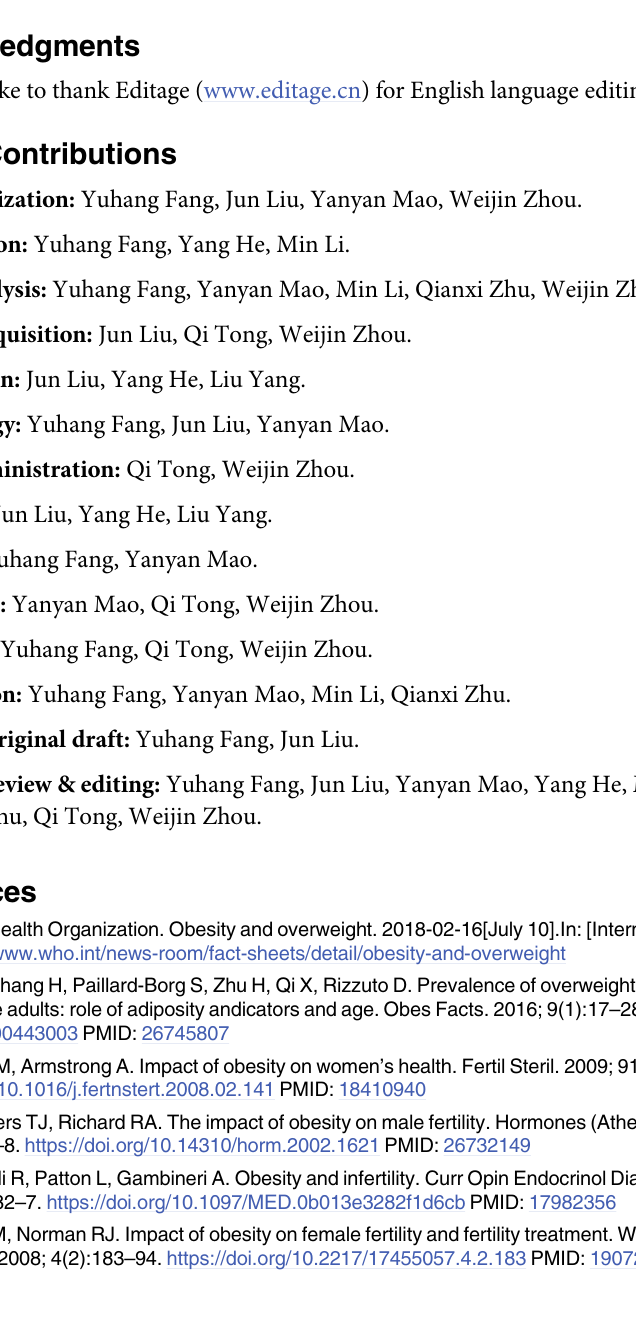
S1 Table. Association between pre-pregnancy BMI and TTP, measured by cycle. S2 Table. Association between maternal pre-pregnancy BMI and TTP, stratified by pater- nal